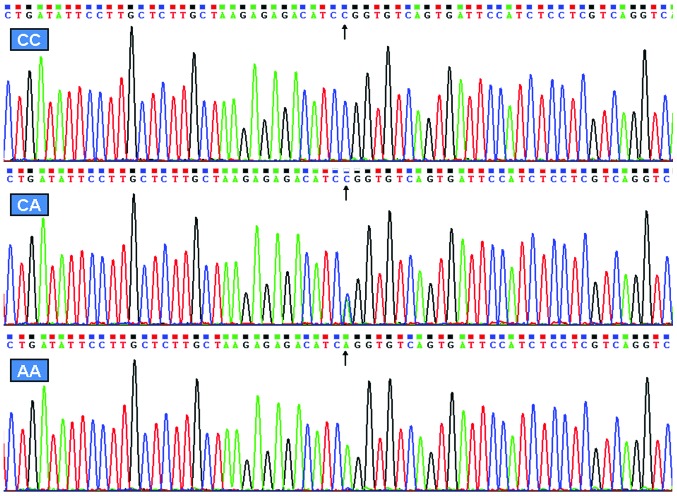
A section of the nucleotide sequence of the rs7134375 single nucleotide polymorphism in the phosphodiesterase 3A gene. The CC, CA and AA genotypes are shown, respectively.